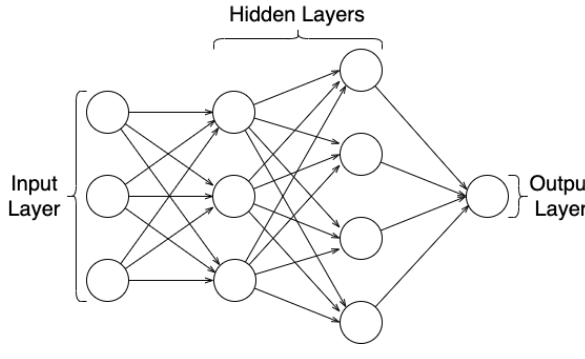
Figure 1. Multilayer